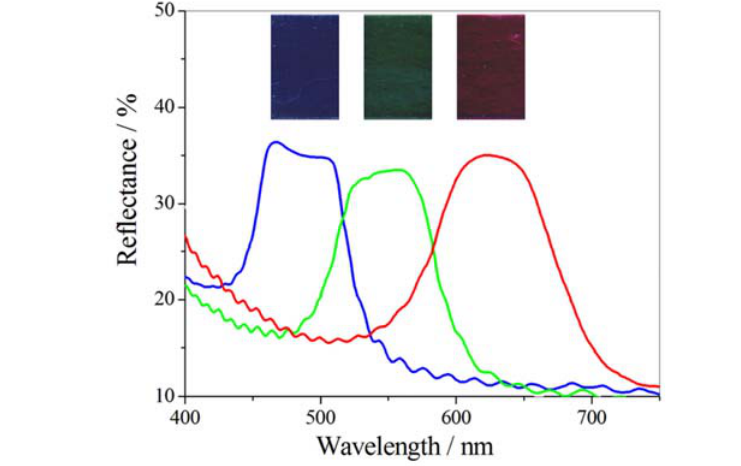
Figure 5. Progressive degradation of photo-sensitive chiral agent by UV light and corresponding reflected